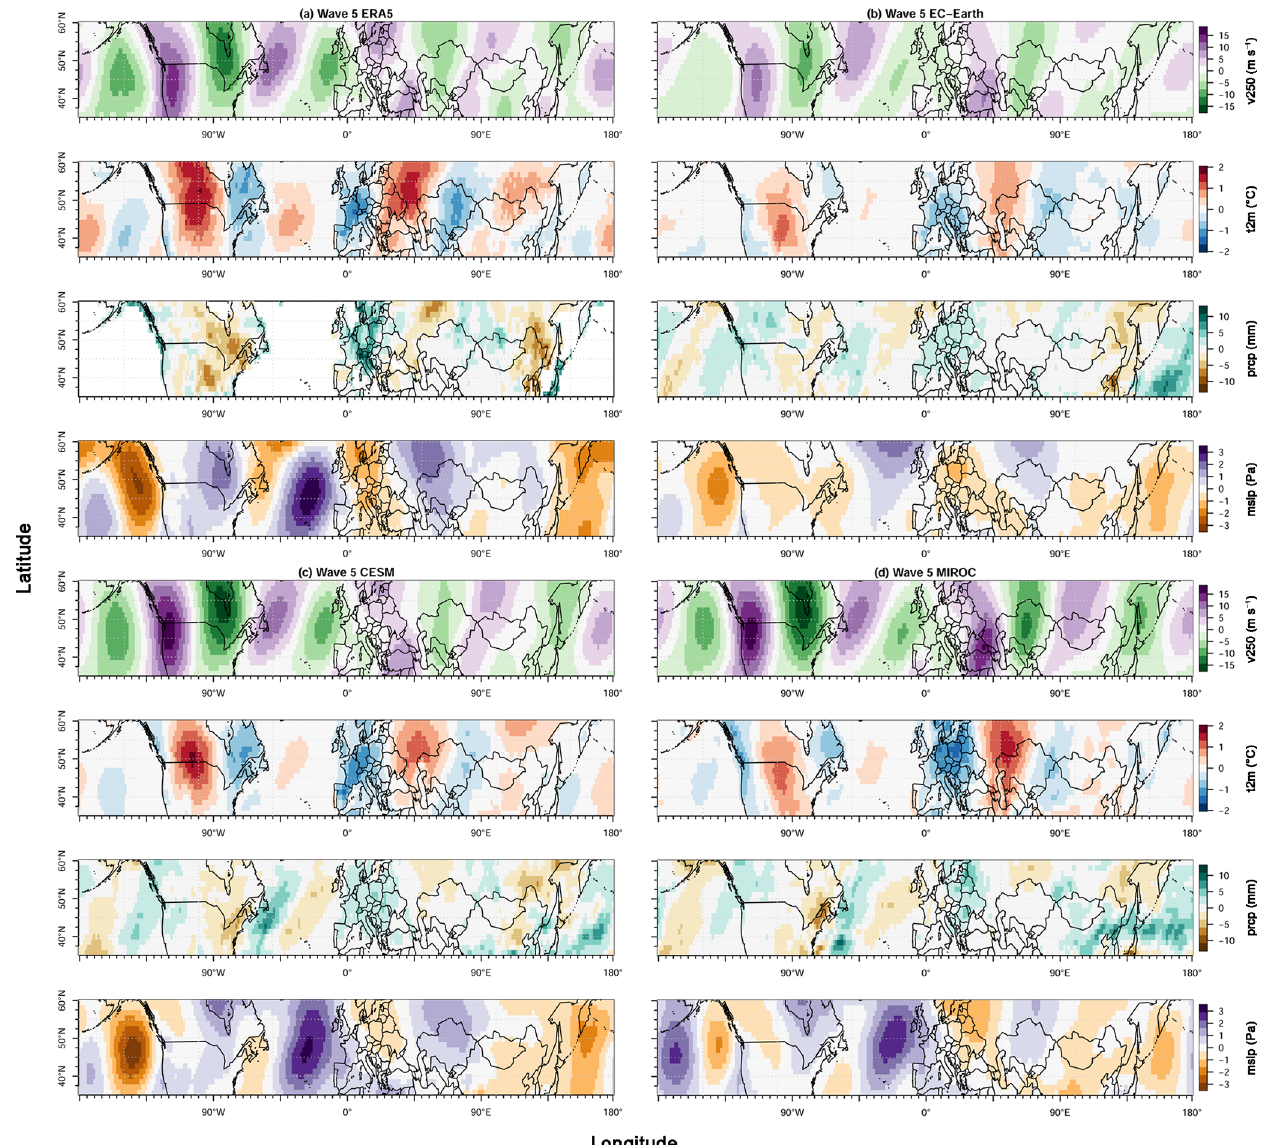
Figure 3. Composite anomaly plots of weeks with high-amplitude wave-5 episodes for meridional wind velocity at 250hPa (v250, absolute field), near-surface temperature (t2m, anomaly), precipitation (prcp, anomaly), and sea level pressure (mslp, anomaly) in ERA5 (a) , EC- Earth (b) , CESM (c) , and MIROC (d) based on the AISI control